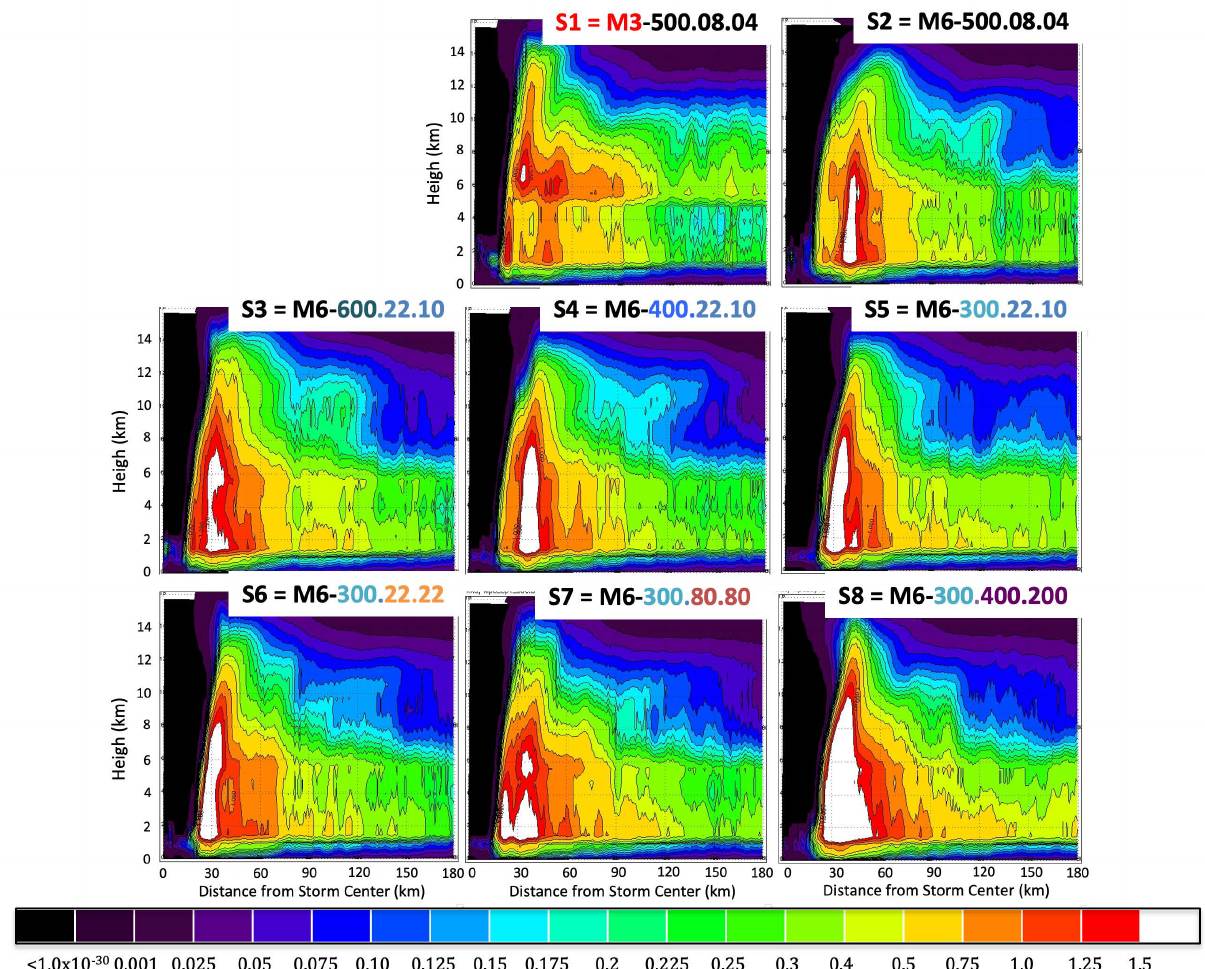
Figure 3. Azimuthal average of the condensed-water fields in each of the simulated storms ( S1 – S8, defined in Table 1 ), as a function of height above mean sea level and of radial distance from the eye. The color in the title of the eight subfigures represents the following selections: (i) sensitivity to microphysics: M3 is in red, M6 is in black; (ii) sensitivity to assumed density of graupel: (cid:36) = 600 kg/m 3 in dark blue, 400 in navy blue, 300 in light blue; (iii) sensitivity to the impact of the intercept parameters for rain (N 0r ) and graupel (N 0g ): N 0r = 22 × 10 6 m − 4 and N 0g = 22 × 10 6 m − 4 —in light orange, N 0r = 80 × 10 6 m − 4 and N 0g = 80 × 10 6 m − 4 —in dark orange, N 0r = 400 × 10 6 m − 4 and N 0g = 200 × 10 6 m − 4 —in